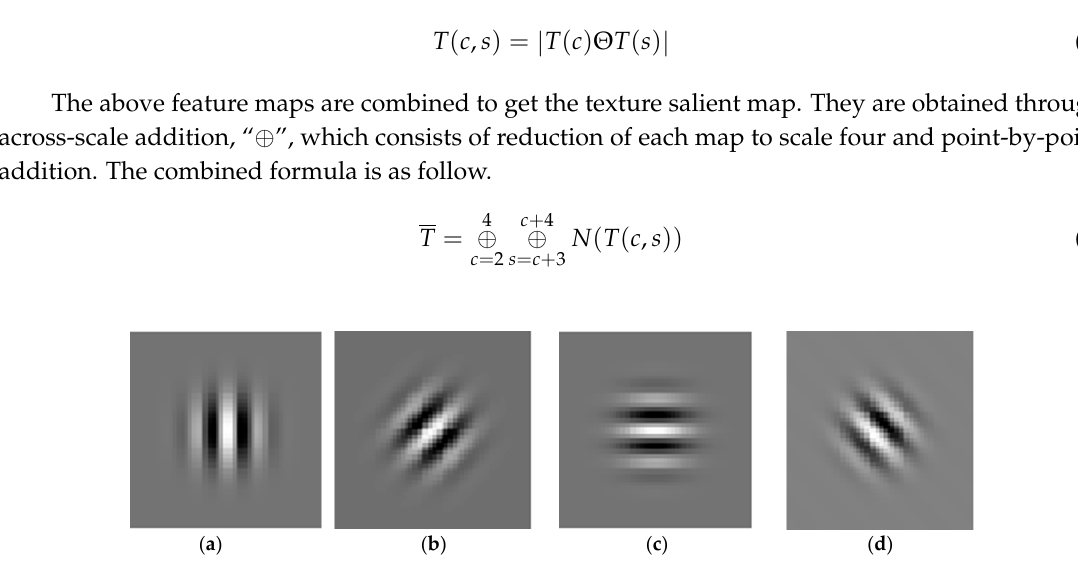
Figure 4. Gabor wavelet based on different directions. ( a ) θ = 0, ( b ) θ = π /4, ( c ) θ = π /2, ( d ) θ = 3 × π /4.